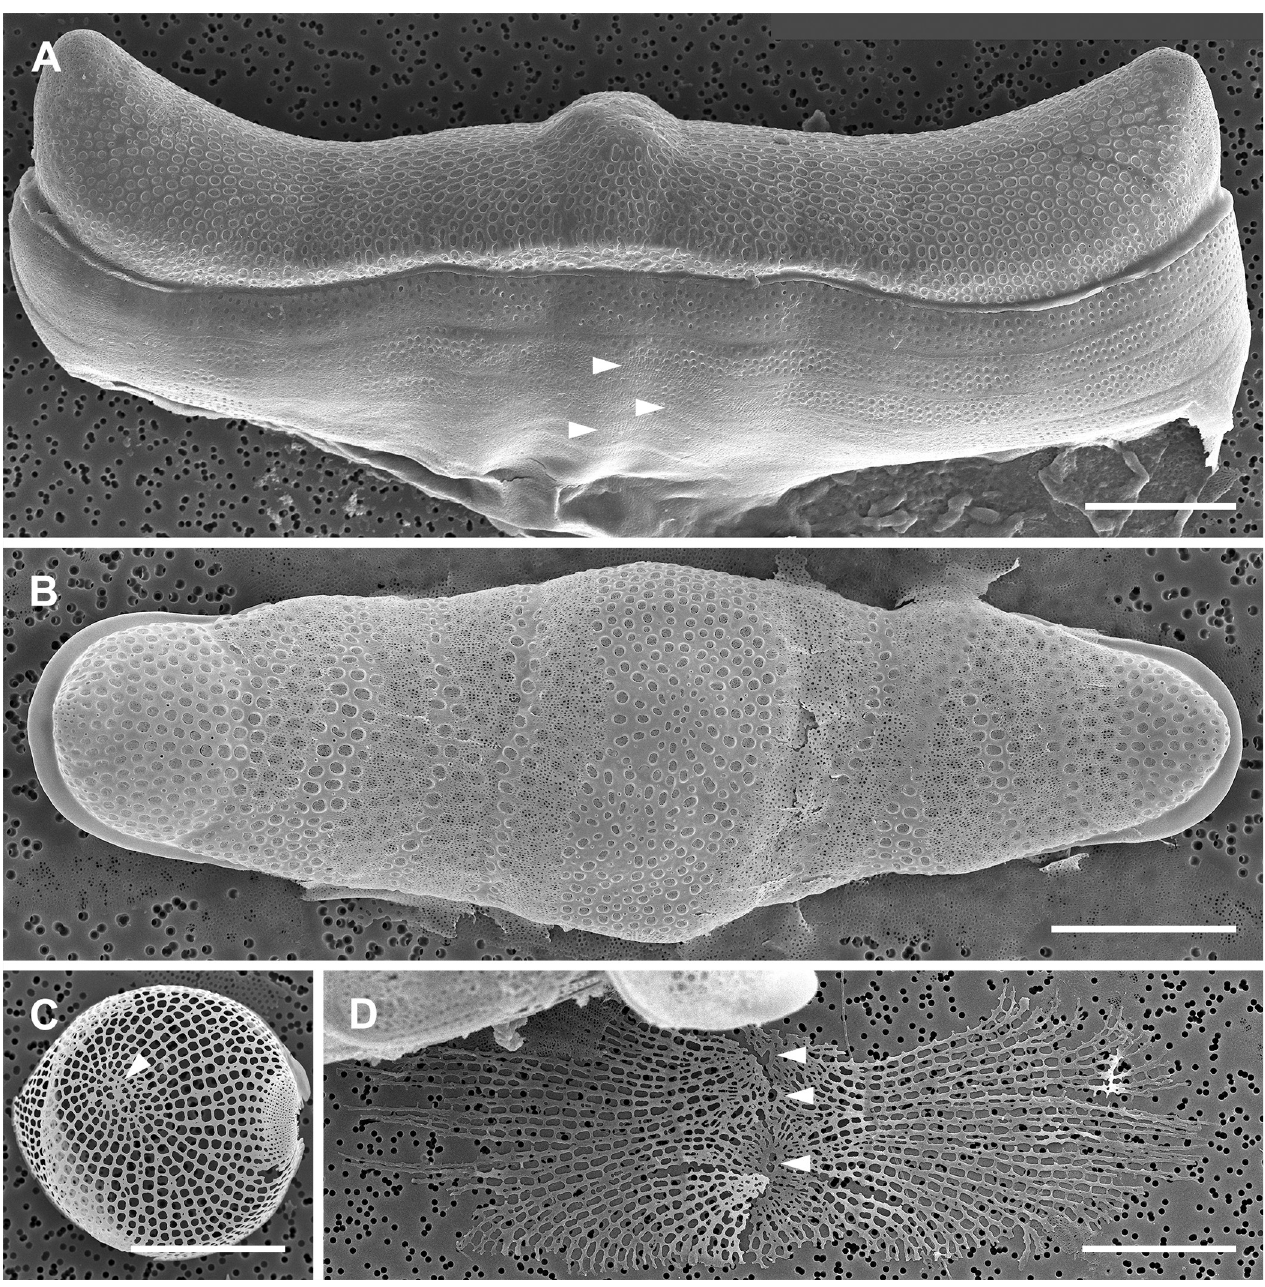
Fig 12. Parental and initial valves (SEM, acid cleaned specimens). (A) External view of auxospore with initial epitheca and partially damaged bottom side of auxospore wall. Remnants of TP bands visible near the left apex while LP bands are best seen below central elevation of the valve (arrowheads). Digital montage of two separate images. (B) Initial valve swathed by remains of disarticulated TP. Note they are still nearly perpendicular to the valve apical axis near valve mid- section while slightly arching towards the apices near valve ends. Digital montage of two separate images. (C) A representative valve from the population of parental cells at early stage of morphogenesis showing valve face with one (?) annulus (arrowhead) and one elevated apical pore field. (D) Basal silica layer of a large postsexual valve showing three small annuli (arrowheads). All scale bars: 25 μ